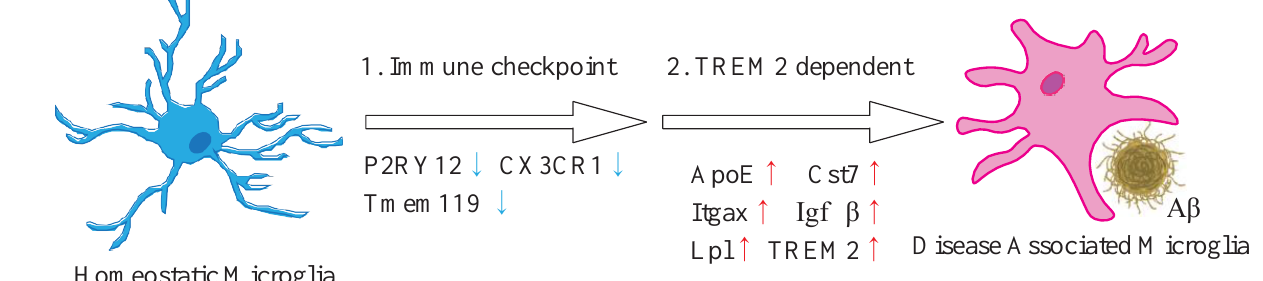
Figure 3. DAMs are activated sequentially by two steps. Schematic illustration showing the two steps by which microglia switch from homeostatic to DAMs. The first step: TREM2-independent downregulation of homeostatic markers such as P2RY12, CX3CR1, and Tmem119. The second step: TREM2-dependent overexpression of genes involved in phagocytosis and lipid metabolism. Arrows indicate up- or down-regulation of the gene.